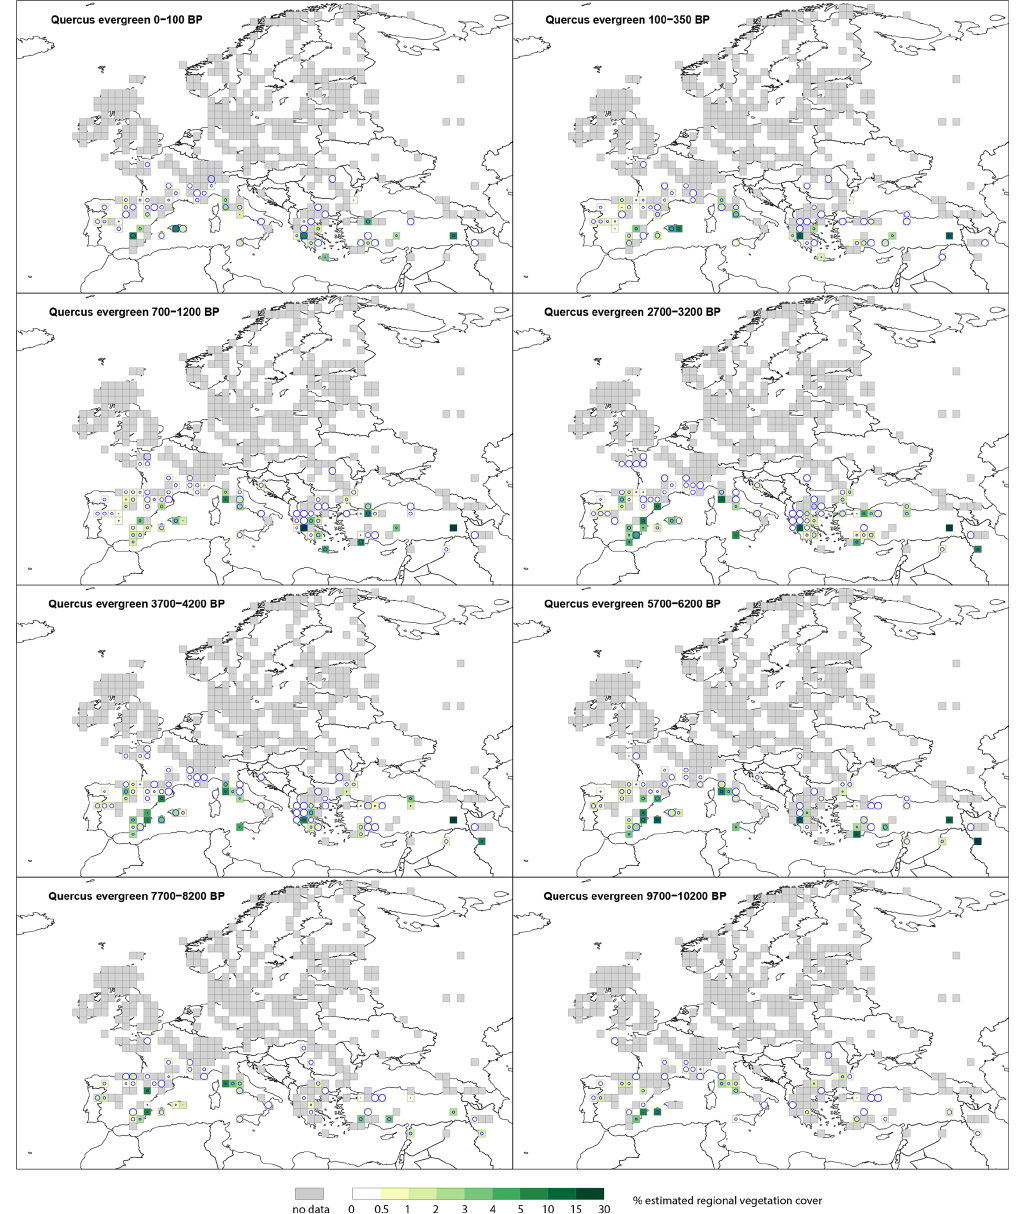
Figure D3. Grid-based REVEALS estimates of evergreen Quercus cover for eight Holocene time windows. Percentage cover in 0.5% intervals between 0% and 1%, 1% intervals between 1% and 5%, 5% intervals between 5% and 15%, and 15% intervals between 15% and 30%. See caption of Fig. A1 for more explanations. Intervals represented by increasingly darker shades of green from 1%–2%. Grey grid cells have no data (pollen) for Calluna vulgaris in the mapped time window. The circles represent the coefficient of variation (CV; the standard error divided by the REVEALS estimate). When SE ≥ REVEALS estimate, the circle fills the entire grid cell, and the REVEALS estimate is not different from zero. This occurs mainly where REVEALS estimates are